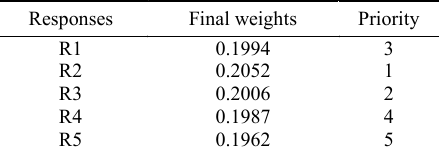
Table 3: Final weights and the priorities